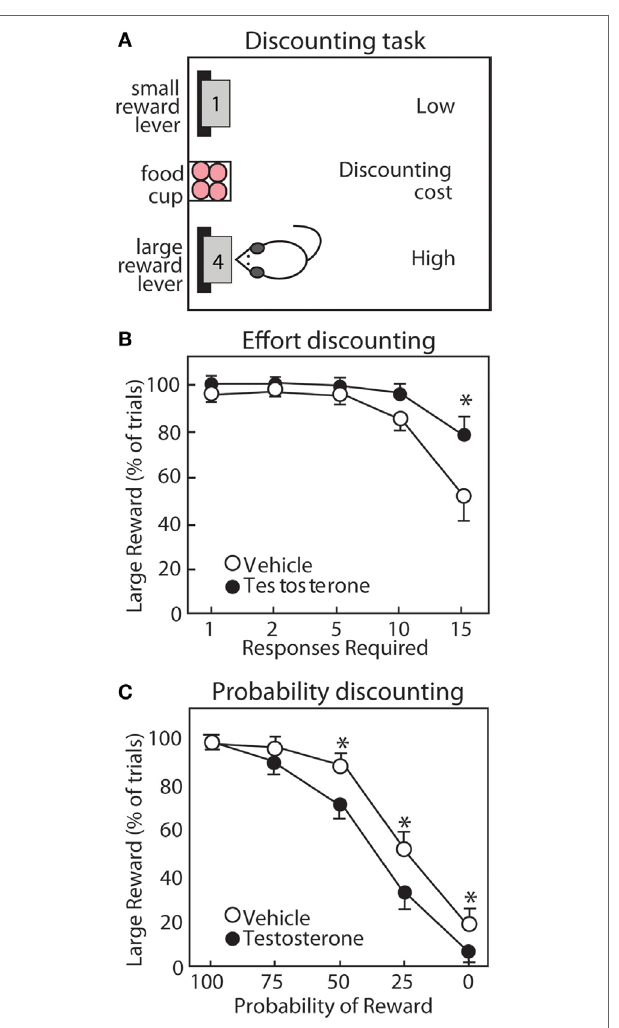
FiGURe 7 | Testosterone influences discounting behavior of male rats. (A) Operant task for discounting behavior. Rats choose between two levers. The small reward lever delivers 1 pellet with minimal cost. The large reward lever delivers four pellets with increasing cost throughout the session. (B) For effort discounting behavior, the response requirement (number of lever presses) increases. (C) For probability discounting, the large reward is delivered with decreasing probability. Compared with vehicle controls (open circles), testosterone (closed circles) increases preference for the large reward lever in effort discounting, but reduces preference for the large reward lever in probability discounting. Adapted with permission from Ref. (190). Values presented as mean ± SEM. * p ≤ 0.05.